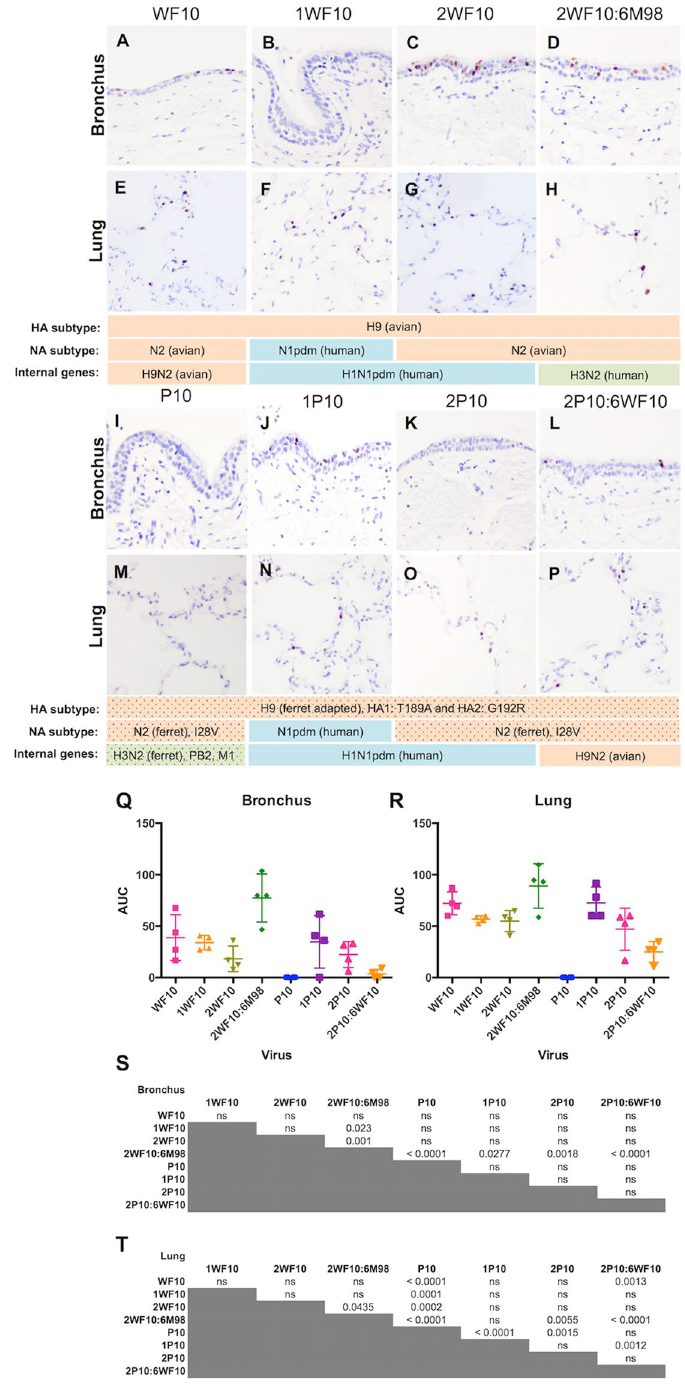
Figure 3. Cellular distribution influenza nucleoprotein in the human bronchus and lung after the infection with recombinant and ferret-adapted H9 viruses and the comparison of their replication competence. Cellular localization of viral antigen in ( A to D ) and ( I to L ) bronchi, and ( E to H ) and ( M to P ) lung infected with reassortant viruses generated using H9N2 and H1N1pdm (WF10, 1WF10, 2WF10), and using H9N2 and H3N2 (2WF10:6M98). ( I and M ) P10 was the ferret-adapted virus harvested after 10 serial passages in ferrets of 2WF10:6M98, with mutation sites at HA1: T189A, HA2: G192R, NA: I28V, PB2: L374I, M1: H110Y, at 24hpi. Virus replication competence ( Q ) in the human bronchus and ( R ) in the human lung were expressed in AUC as described in the method. The chart showed the mean and the SD of the AUC pooled from at least four independent experiments with the result tables ( S and T ) showing the statistical comparison between viruses, * p < 0.05; ** p < 0.01, *** p < 0.005, **** p < 0.001 and ns: p >